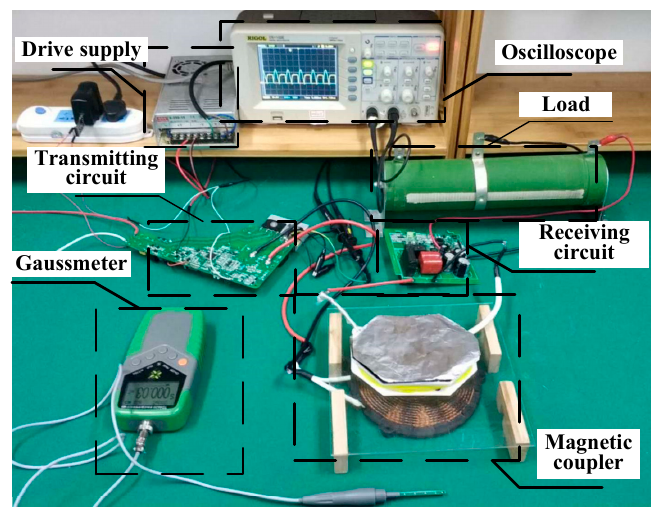
Figure 11. Experimental setup of the WPT system. Figure 11. E xperimental setup of the WPT system.